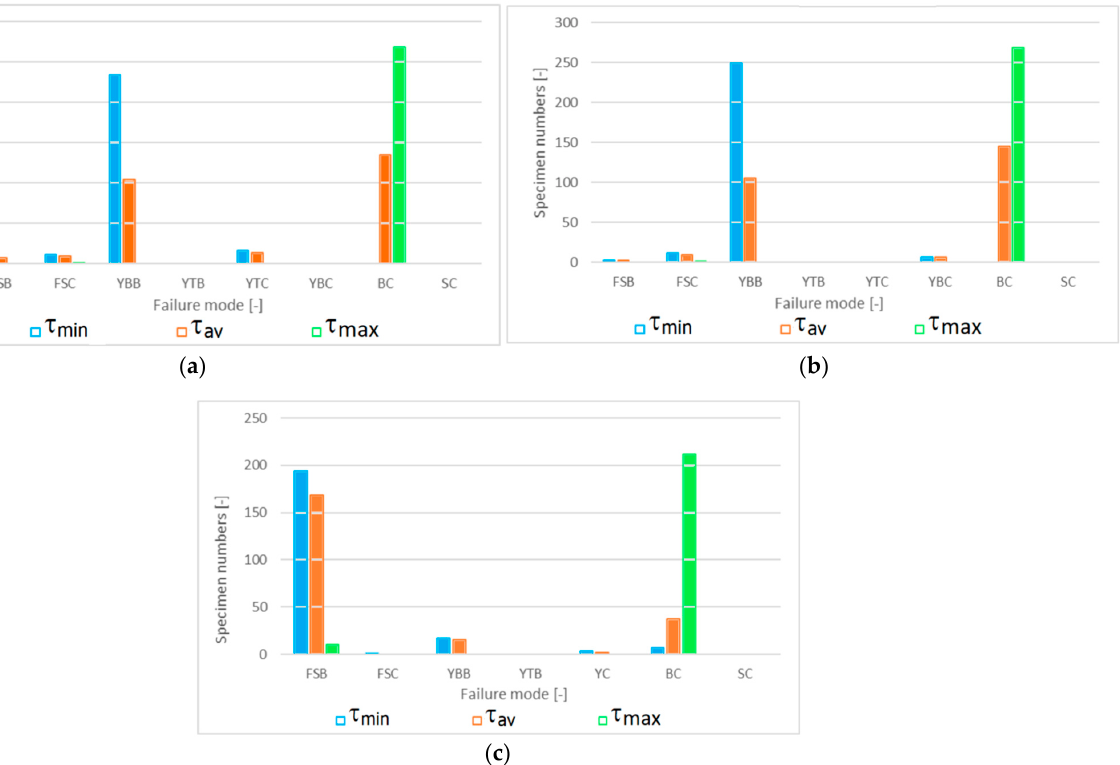
15 of 21 Figure 9. Experimental and numerical comparison for X-shaped RC joints: minimum bond stress (blue), average bond stress (orange), and maximum bond stress (green). The same analysis was performed for X-shaped RC joints. The comparison between the experimental and the analytical predictions show a higher dispersion compared to the case of T-shaped RC joints. However, given the large number of specimens, it was noted that some specimens exhibited non-typical behavior. In fact, in analyzing some experi- mental results, it is clear that some values are not typical for the materials. These differ- ences are apparently due to particular test conditions. A screening of some test values could be useful to eliminate unrealistic results; however, the authors preferred to consider the entire population instead of filtering data, since not all of the information is available. The dispersion changes slightly with the considered bond capacities; thus, the ultimate behavior of X-shaped joints appears to be weakly influenced by the bond capacity of the reinforcement layer. The proposed model allows the assessment of the failure mode to be linked to the